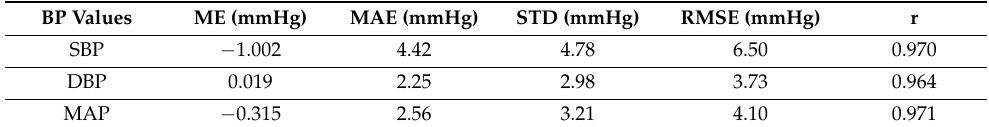
Table 2. Performance detail of Squeeze U-net models for systolic blood pressure (SBP), diastolic blood pressure (DBP), and mean arterial pressure (MAP) values measurement.